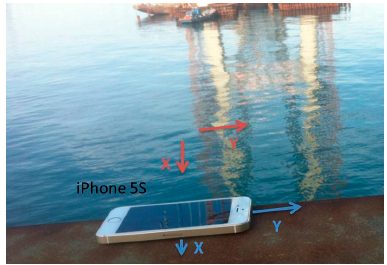
Figure 21. On-site hoisting of the middle span.